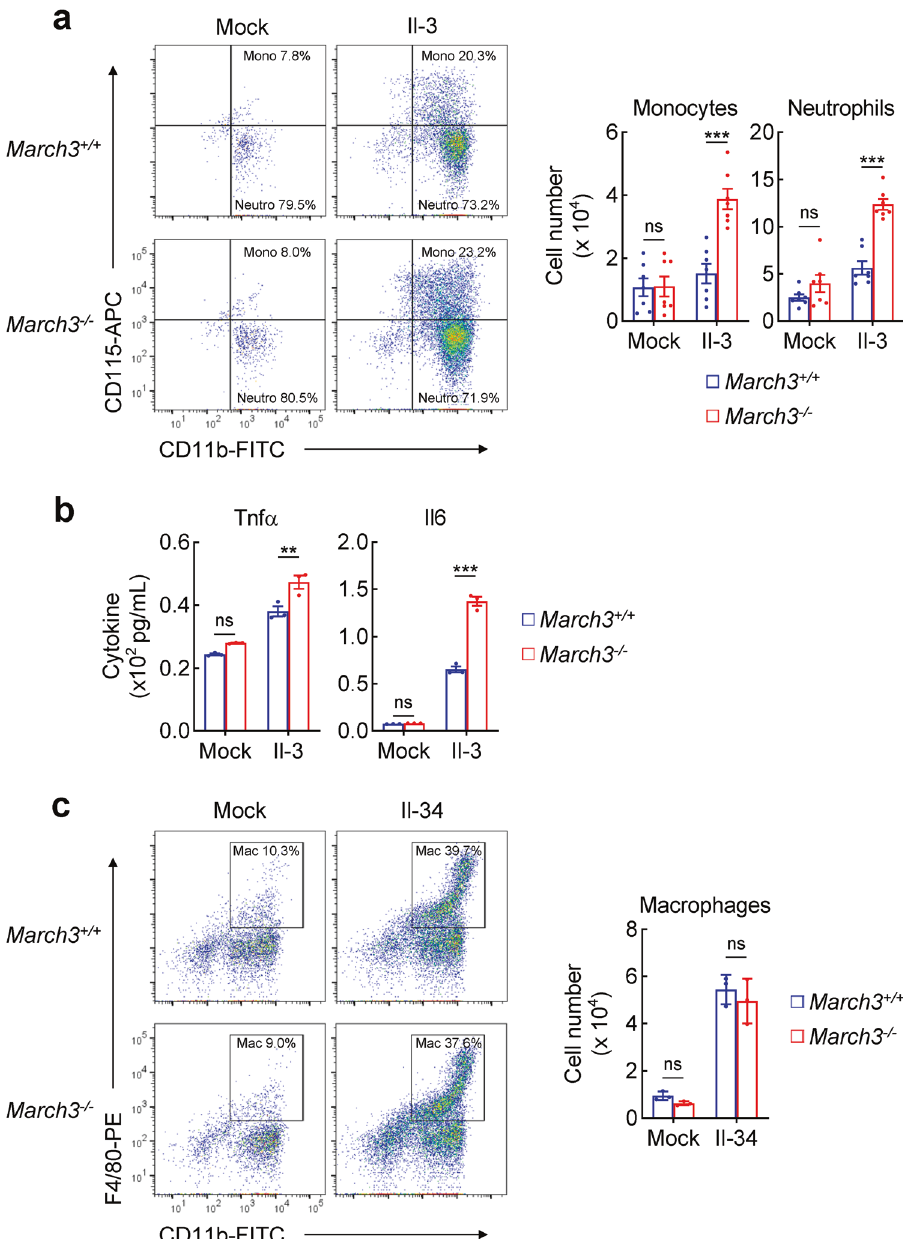
Fig. 5 March3-de fi ciency promotes Il-3-triggered expansion of myeloid cells. a March3 + / + or March3 − / − Lin − bone marrow cells were treated with Il-3 (5 ng/mL) for 4 days before fl ow cytometry analysis (left panel) and counting of cell numbers (right histograph). Data shown in the right histographs are mean ± SEM, n = 7. *** P < 0.001; ns not signi fi cant. b March3 + / + or March3 − / − Lin − bone marrow cells were treated with Il-3 (5 ng/mL) for 4 days. The culture media of the cells were collected for measurement of Tnf- α and Il-6 levels by ELISA. Data shown are mean ± SEM, n = 3. ** P < 0.01, *** P < 0.001; ns not signi fi cant. c The indicated Lin - bone marrow cells were treated with Il-34 (100 ng/mL) for 4 days before fl ow cytometry analysis (left panel) and counting of cell numbers (right histograph). Data shown in the right histograph are mean